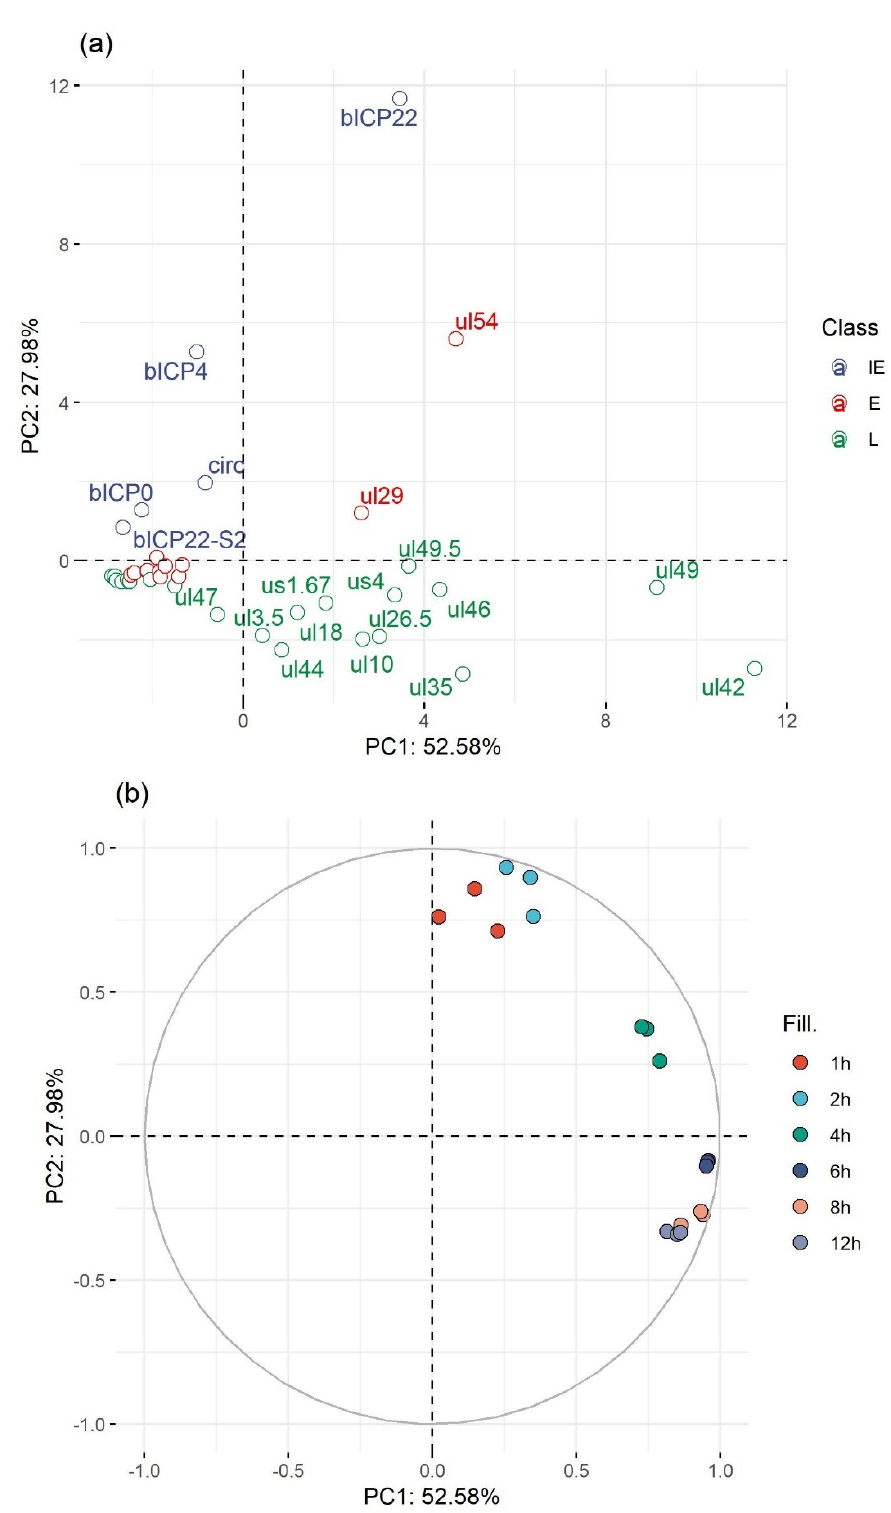
Figure 7. Principal component analysis. PCA of gene abundances (based on TSS counts) normalized to the total viral read count. This exploratory multivariate data analysis method decreases the number of dimensions in a data structure in a way that retains most of the variation in it. The values for each gene are shown on the top panel ( a ), colored according to their assessed kinetic categories, while the values of the samples are shown on the bottom panel ( b ), colored according to hours past infection (hpi).